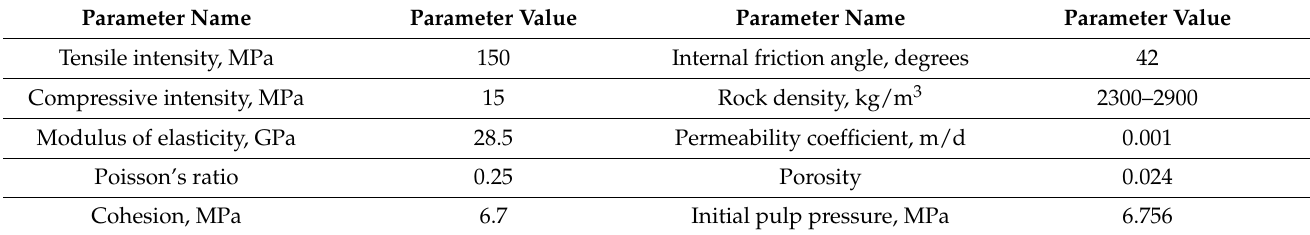
Table 2. Numerical simulation